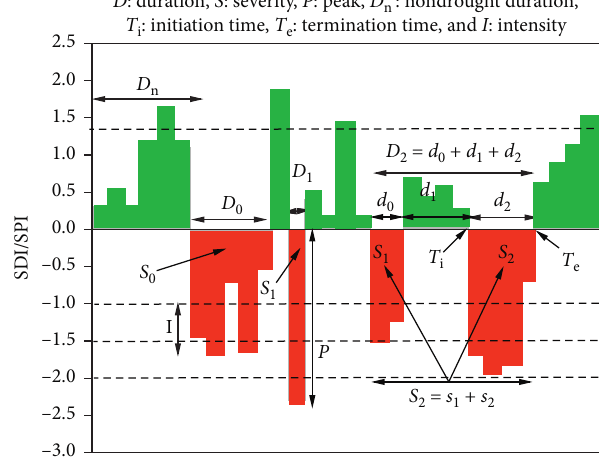
Figure 2: Definition of drought characteristics including peak, intensity, duration, and magnitude using the SPI/SDI and run